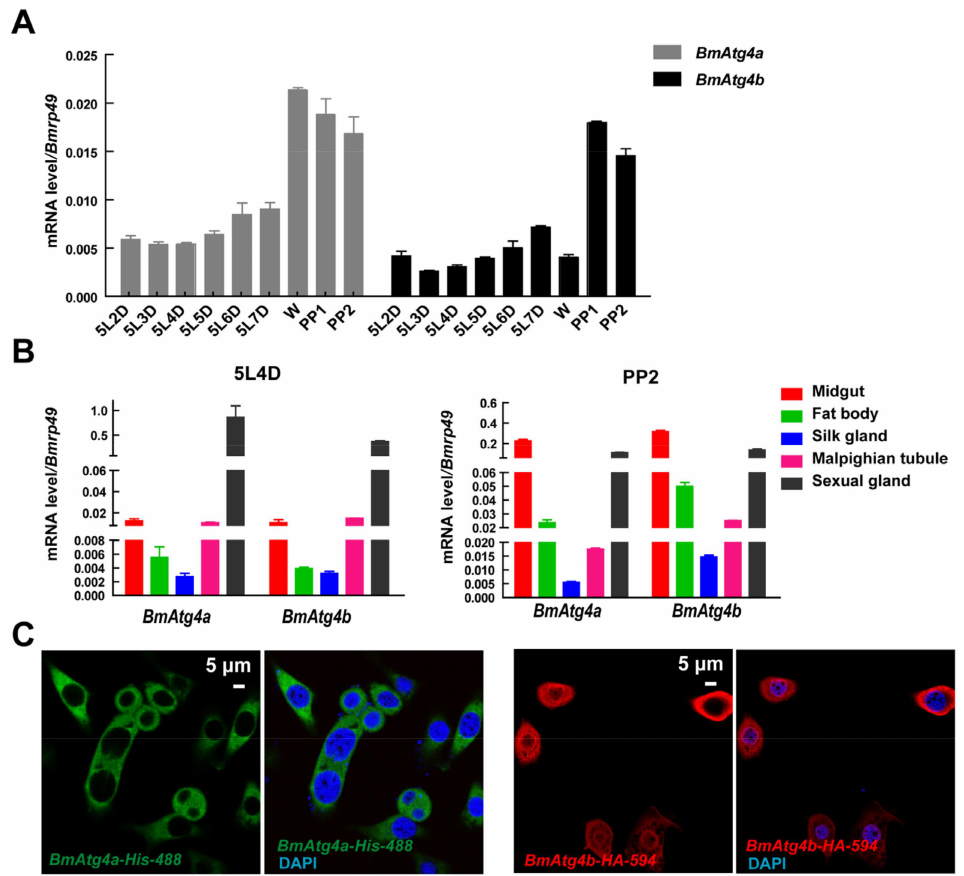
Figure 1. Detection of BmAtg4a and BmAtg4b expression as well as the subcellular localization of their proteins. ( A ) Developmental profiles of BmAtg4a and BmAtg4b from 5L2D to PP2 in B. mori fat body detected by qPCR. ( B ) mRNA levels of BmAtg4a and BmAtg4b in the fat body, midgut, Malpighian tubule, silk gland, and sexual gland at the 5L4D and PP2 stages. ( C ) The subcellular localization of the overexpressed BmAtg4a and BmAtg4b proteins in BmN cells was detected by IF